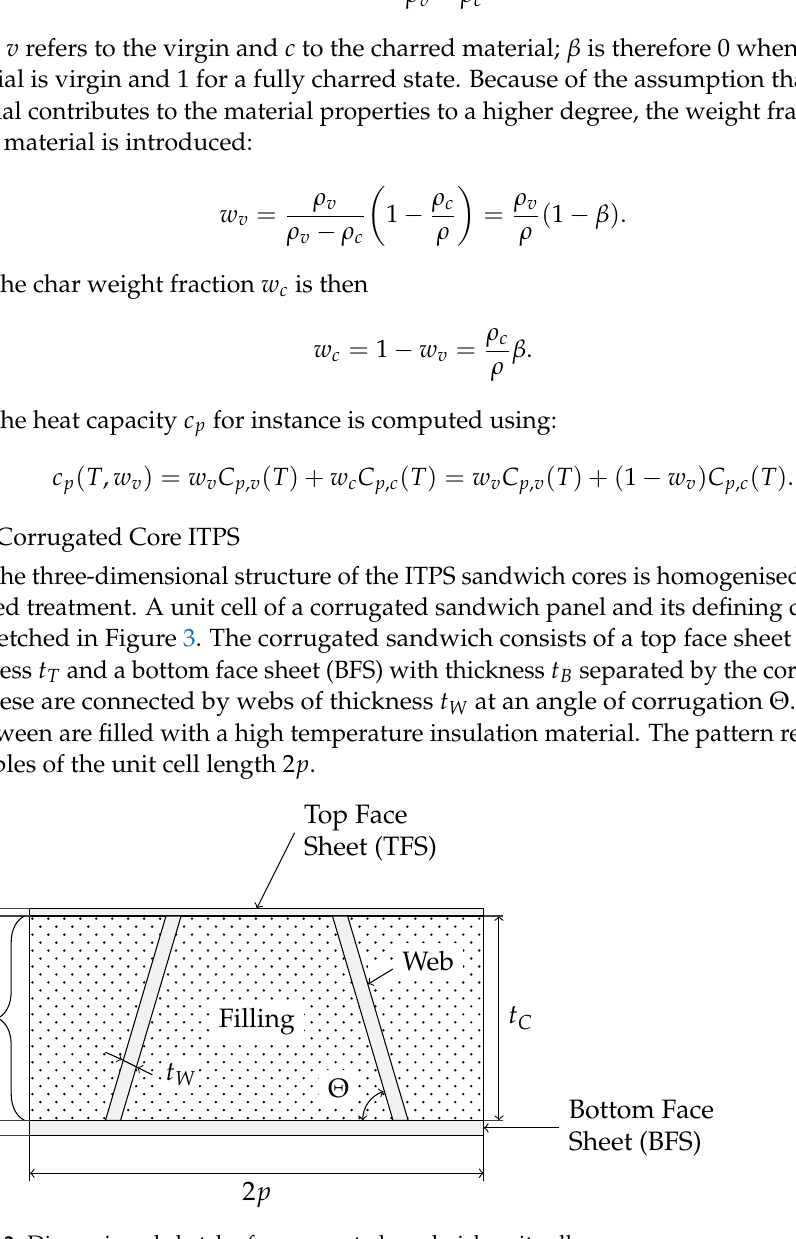
Figure 3. Dimensioned sketch of a corrugated sandwich unit cell.